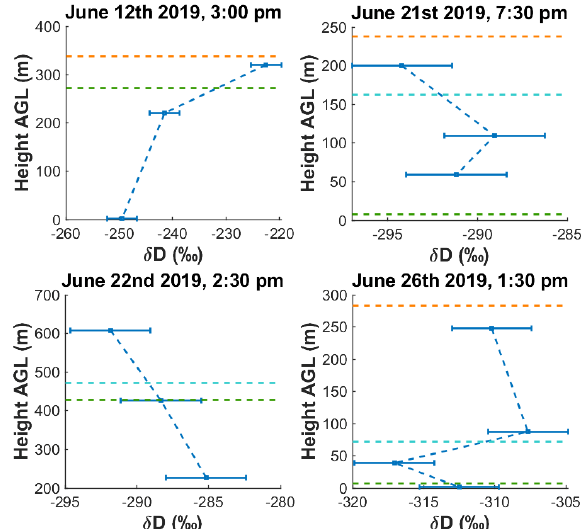
Figure A7. A comparison between different methods of determin- ing the location of the PBL. The location predicted from the first off-diagonal of Euclidean distance is indicated by the green dashed line. When the CHCI prediction is different, it is plotted in orange. When the operator determined a different location of the PBL, it is plotted in cyan. To illustrate the structure observed relative to these predictions, average isotopic values of δ D for flasks taken at each height are shown in blue.